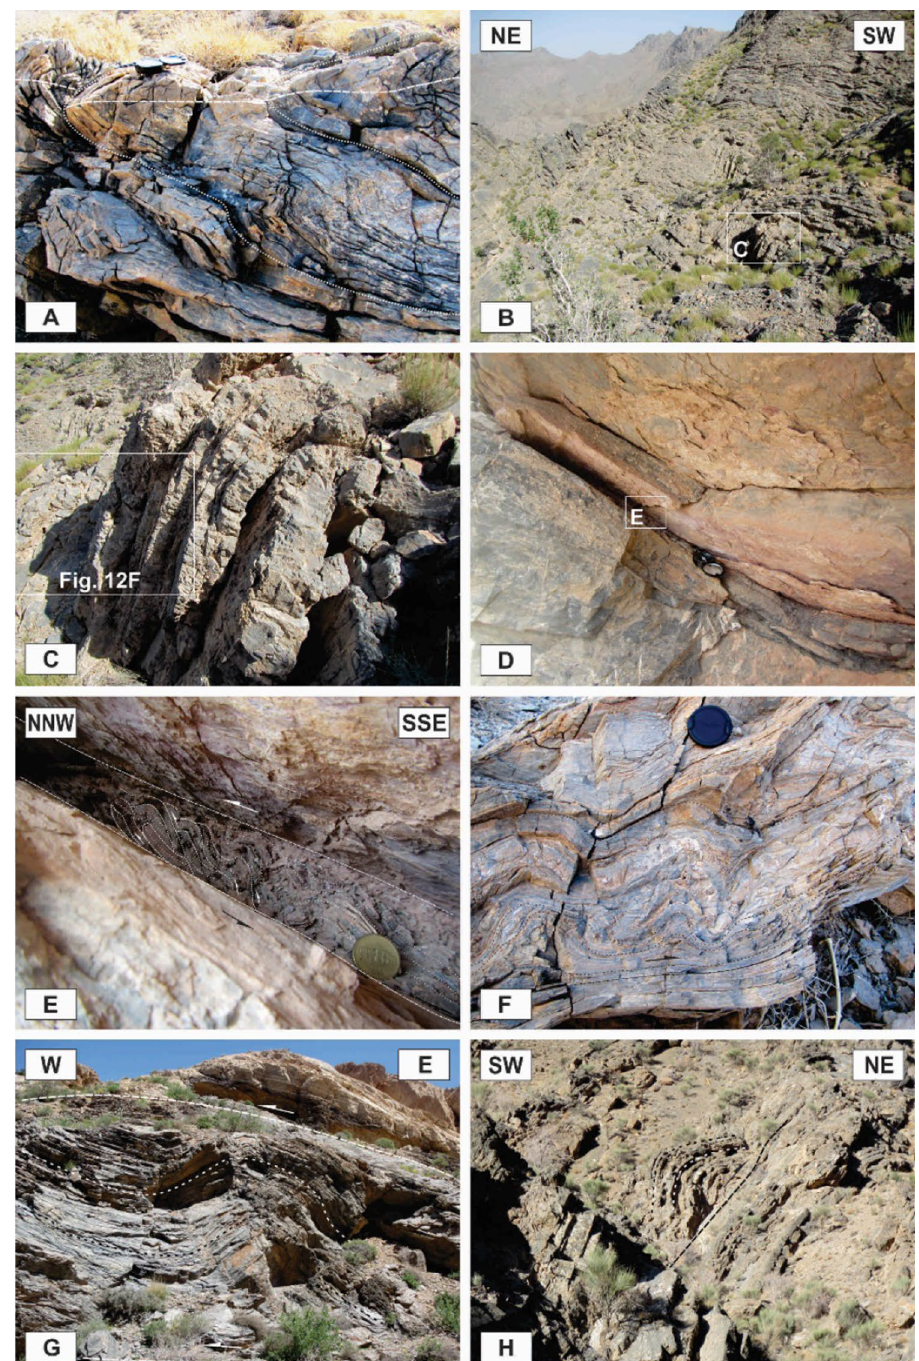
Figure 9. Annotated field photographs of the various kinds of the outcrop-scale folds in the different parts of the study area. (Photos are taken by Mohammad Ali